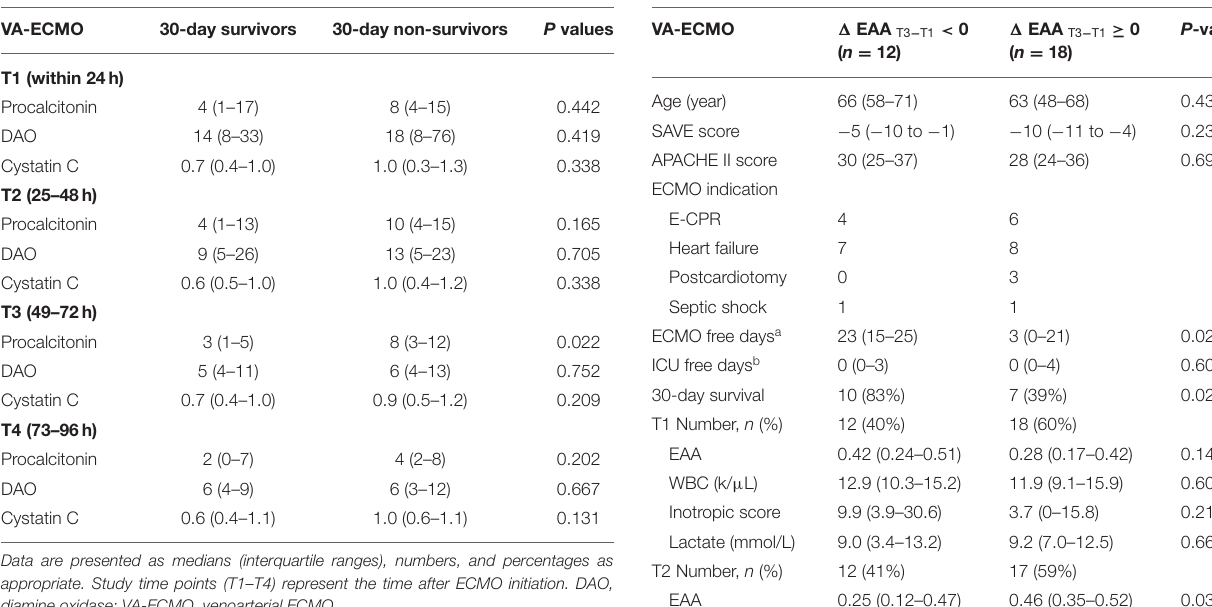
TABLE 3 | Biomarker levels in 30-day survivors and non-survivors with VA-ECMO.